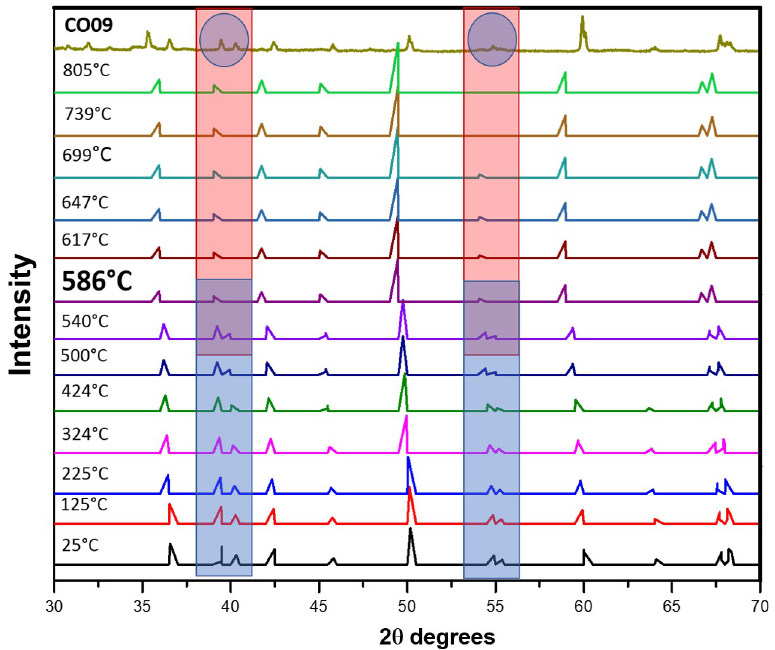
Fig 10. Comparison of CO09 diffraction patterns with quartz at different temperatures [43]. The similarities in the colored areas revealed in the overlap of colors (rectangular and circular) allow us to estimate the firing temperature of the CO09 figurine between 540˚C and 586˚C.